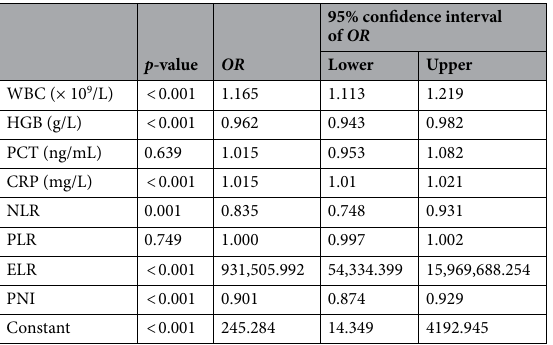
Table 2. Multivariate logistic regression analysis between the KD and the febrile controls.